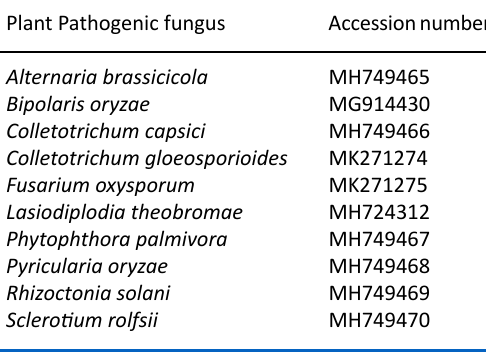
Table 2. Plant pathogenic fungi used in this study Plant Pathogenic